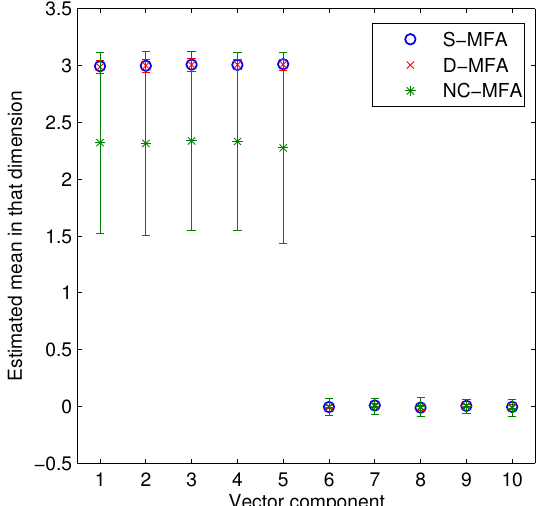
Figure 6. The mean and standard deviation of all of the vector components in estimated µ over 100